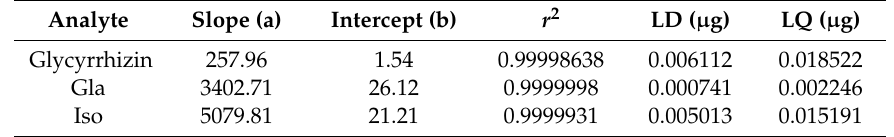
Table 1. Slope, intercept and coe ffi cient of determination ( r 2 ) of the calibration curves *, limits